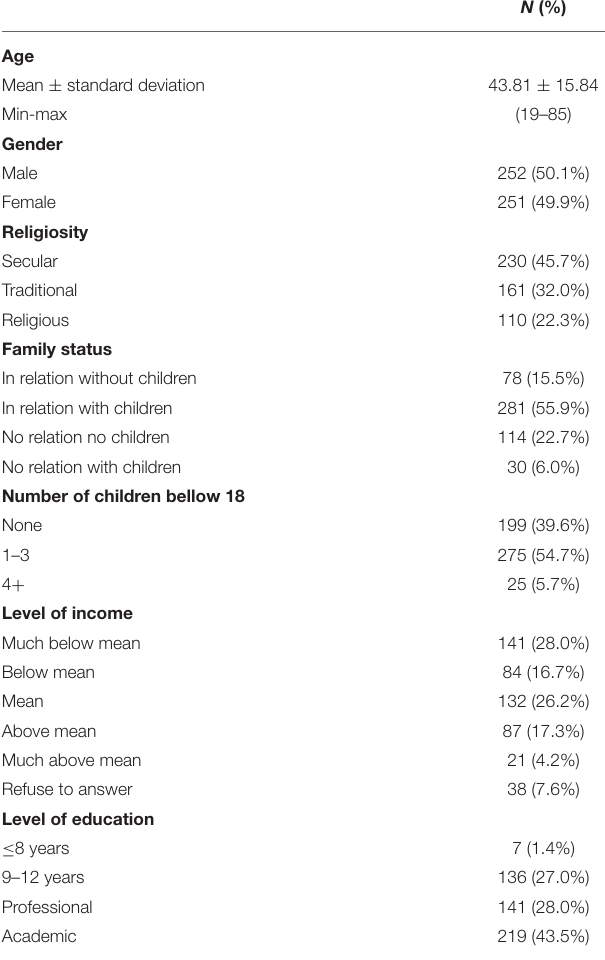
TABLE 1 | Characteristics of study population ( N =